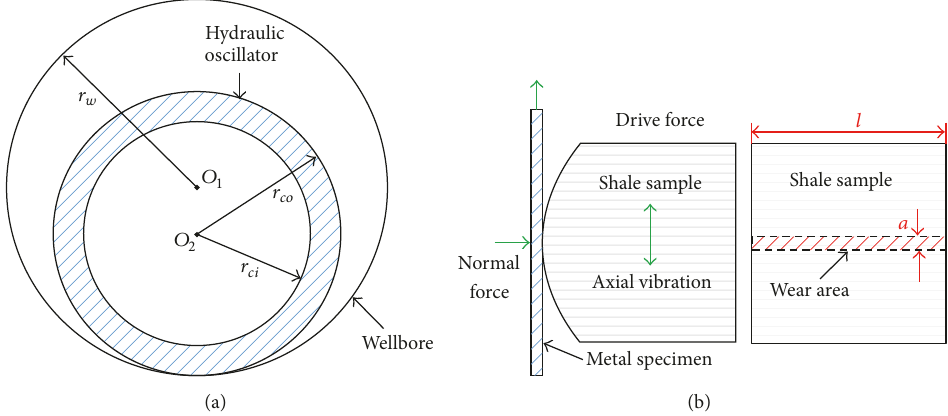
Figure 2: Contact mode simplification model: (a) contact mode between hydraulic oscillator and wellbore rock; (b) contact mode between shale sample and metal specimen.